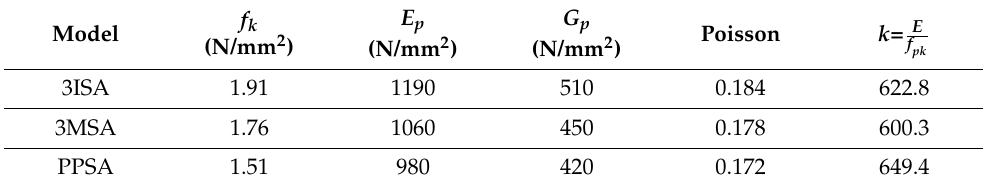
Table 6. Values of the deformation